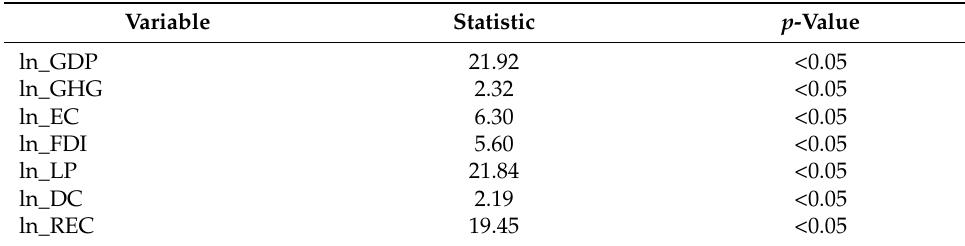
Table 2. The CD Pesaran’s test—results (1996–2019) 1 .